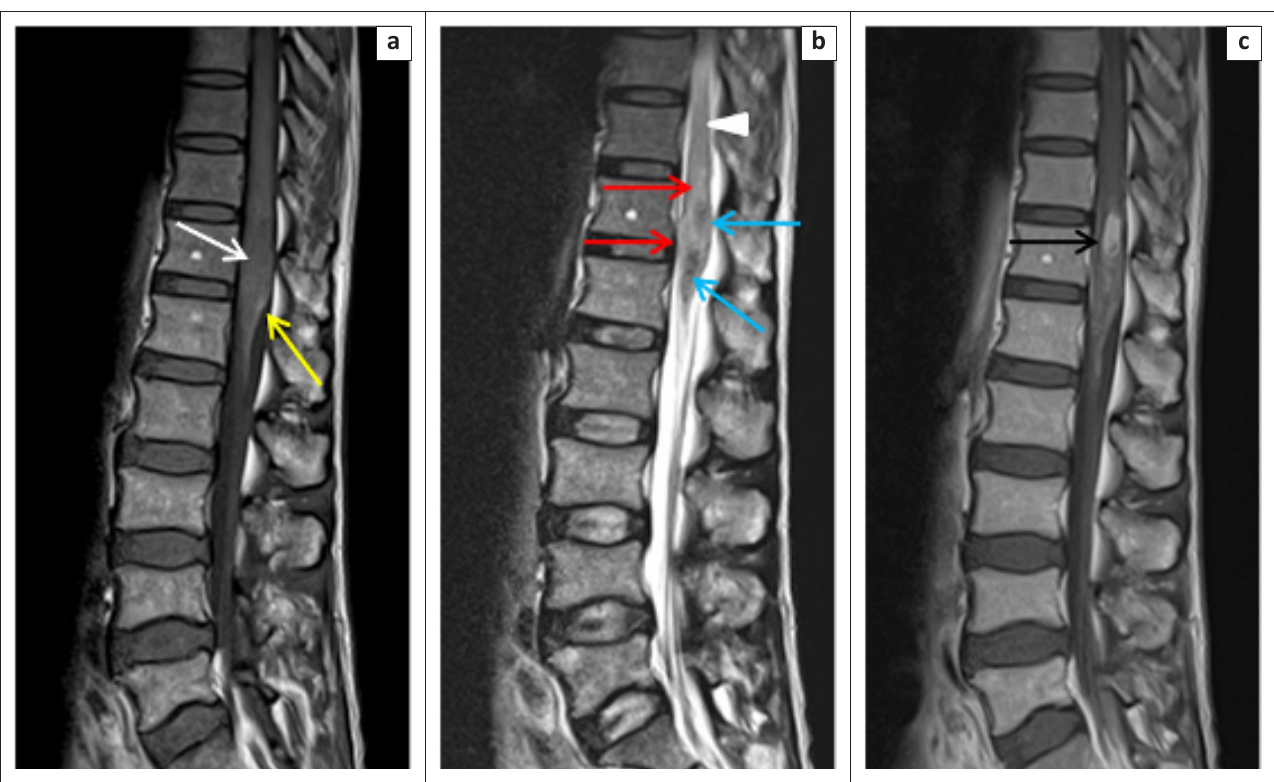
FIGURE 8: Intramedullary conus medullaris metastasis from a primary bronchus carcinoma in a 56-year-old man. Sagittal T1-weighted image (a) demonstrates irregular expansion of the conus medullaris (white arrow) with a focus of hyperintensity posteriorly (yellow arrow). Sagittal T2-weighted image (b) reveals abnormal hyperintensity throughout the expanded region (red arrows) with associated heterogenous hypointense areas (blue arrows). Cord oedema is also seen extending superiorly (white arrowhead). Contrast-enhanced sagittal T1-weighted image (c) displays patchy but intense enhancement (black arrow).